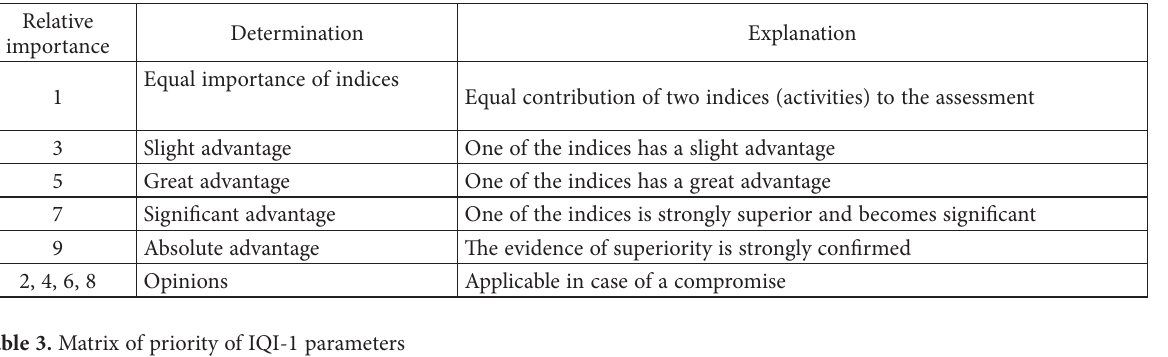
Table 3. Matrix of priority of IQI-1 parameters